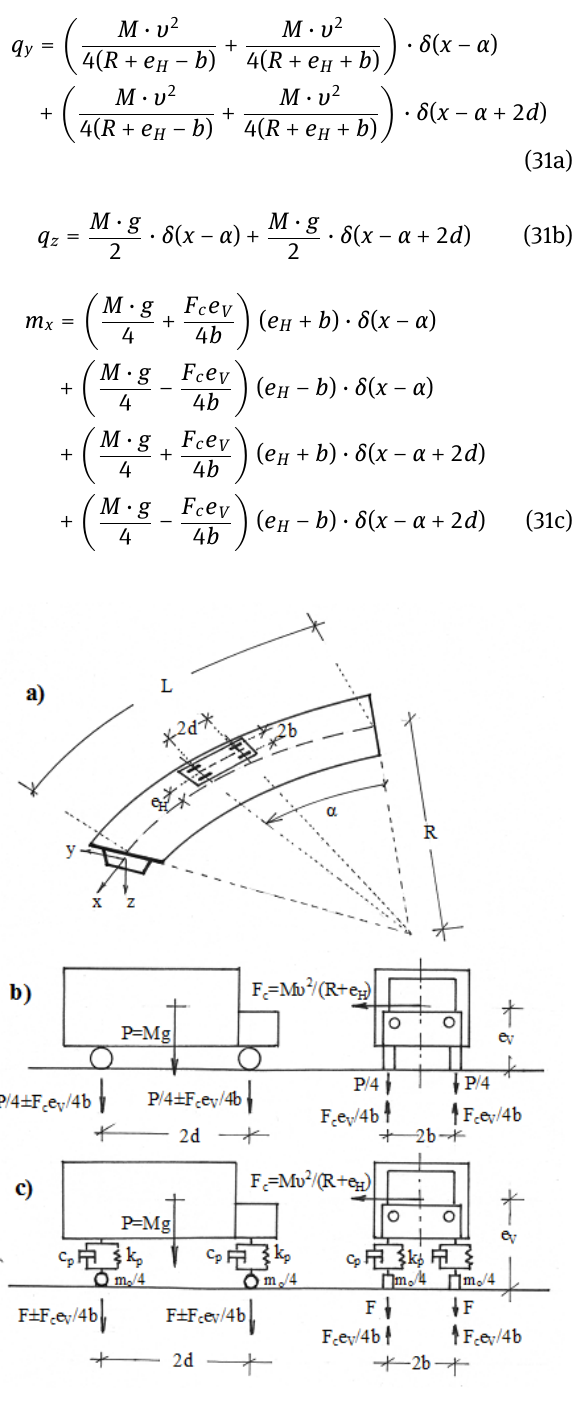
Figure 5: The curved bridge (a), the moving vehicle (b) and the damped vehicle